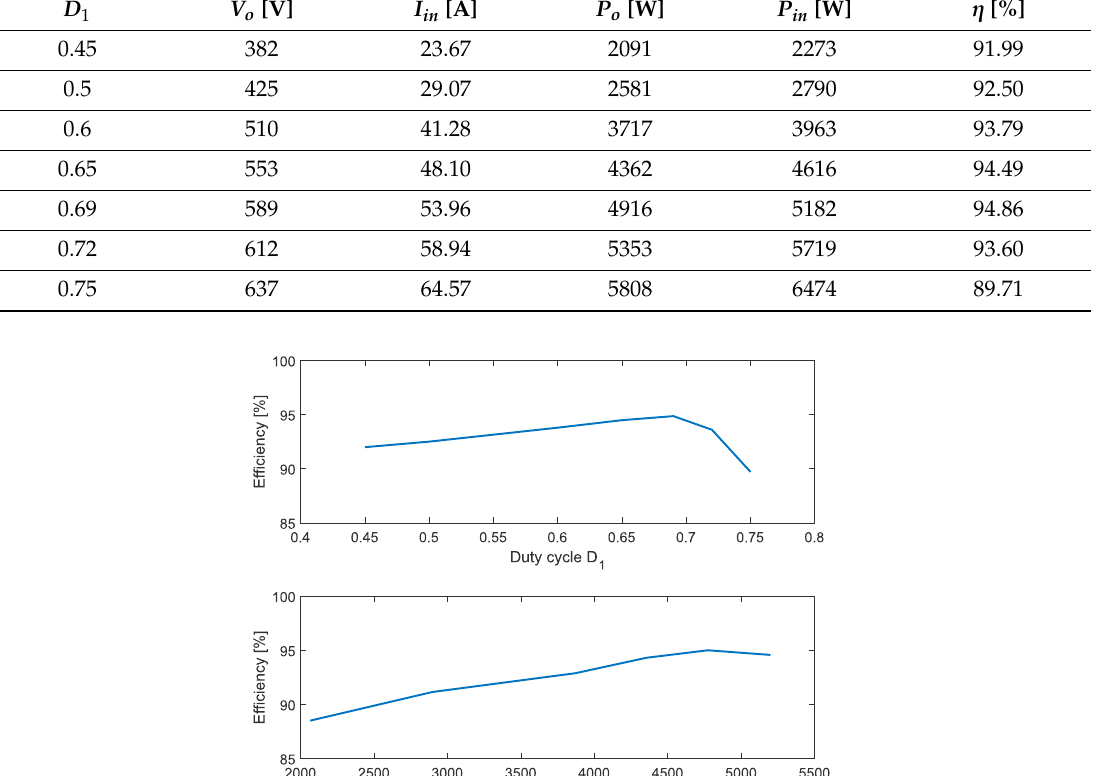
Table 3. E ffi ciency results with constant load.